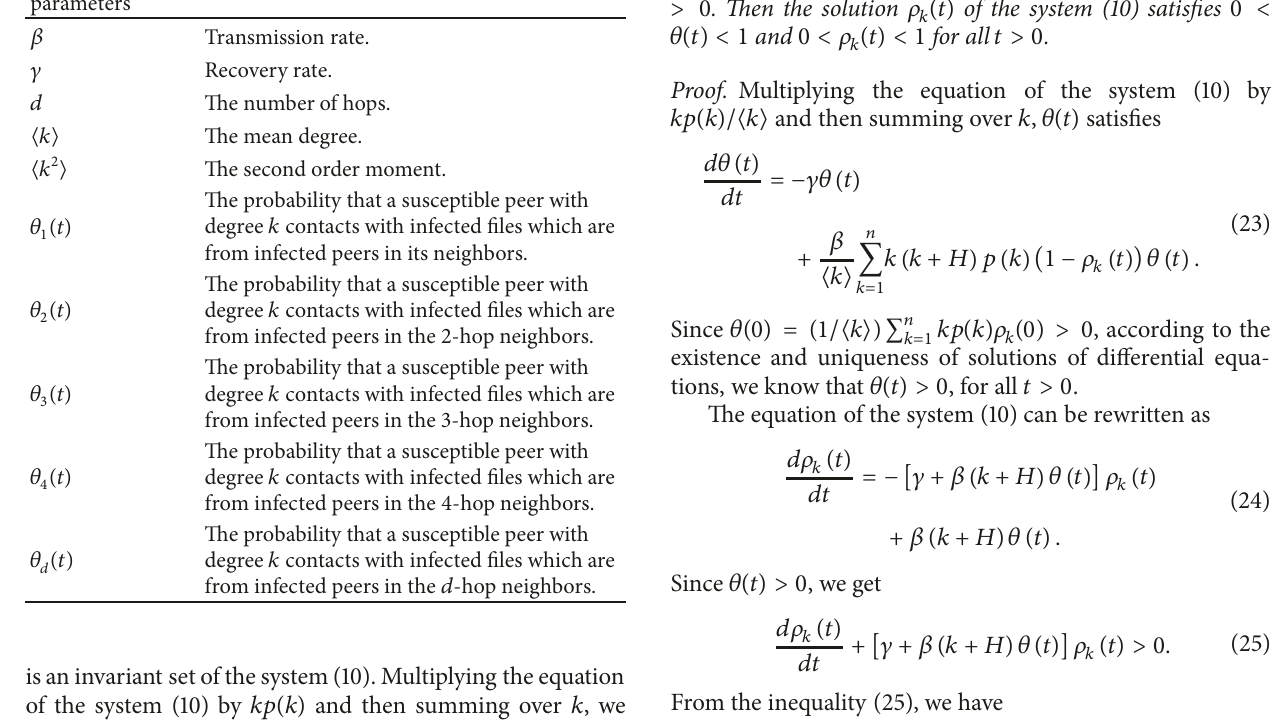
Table 1: Descriptions of variables and parameters in model (8). Variables and